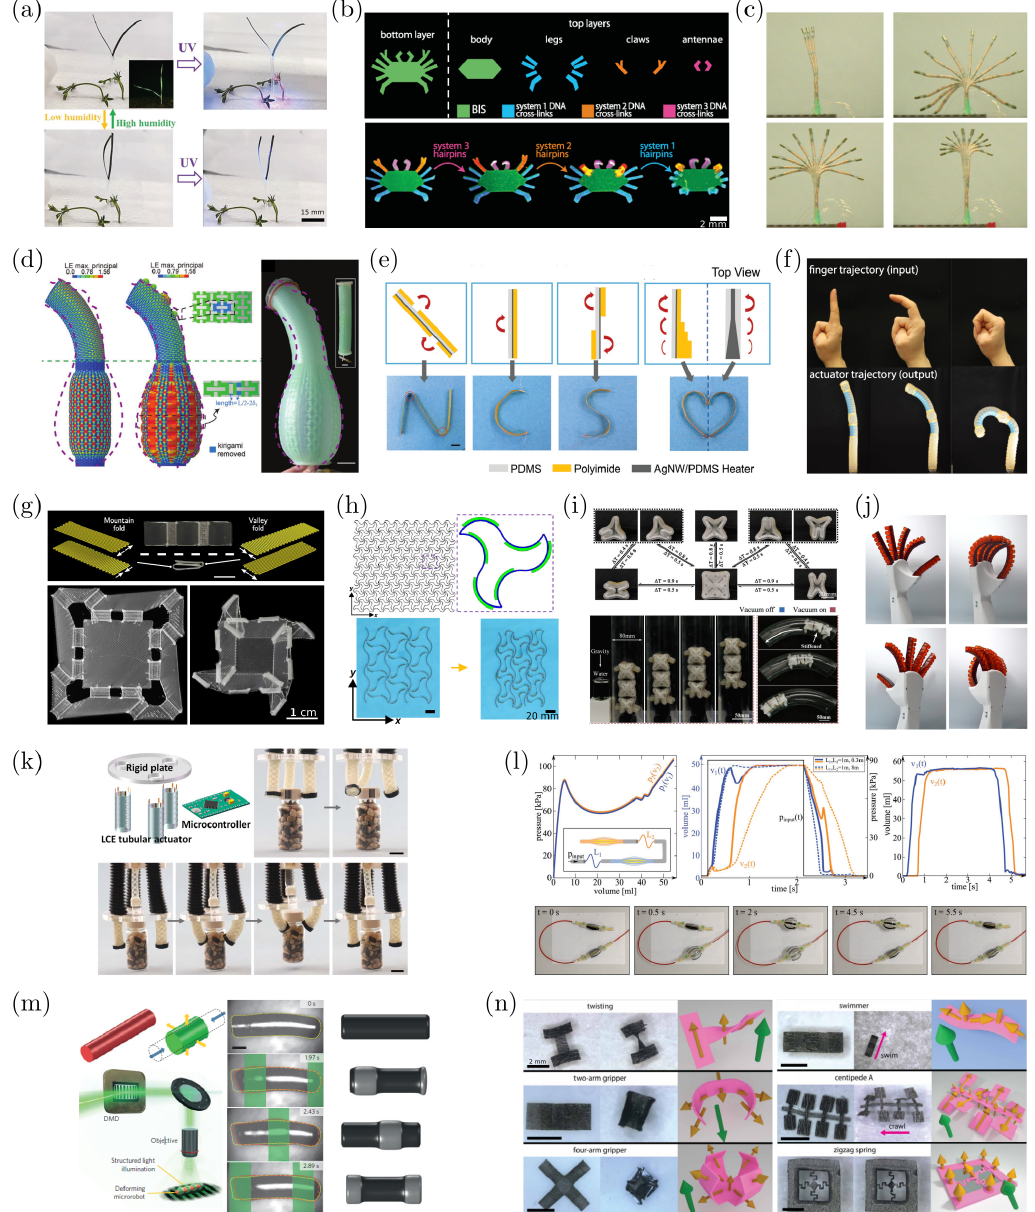
Figure 11. Examples of strategies towards the generation of complex motions. ( a )